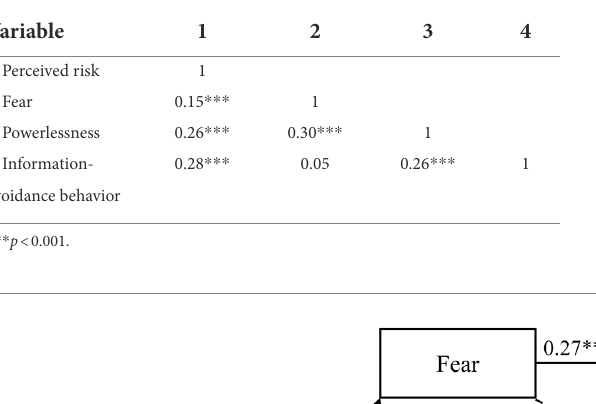
TABLE 3 Pearson correlations for all study variables ( n = 557).